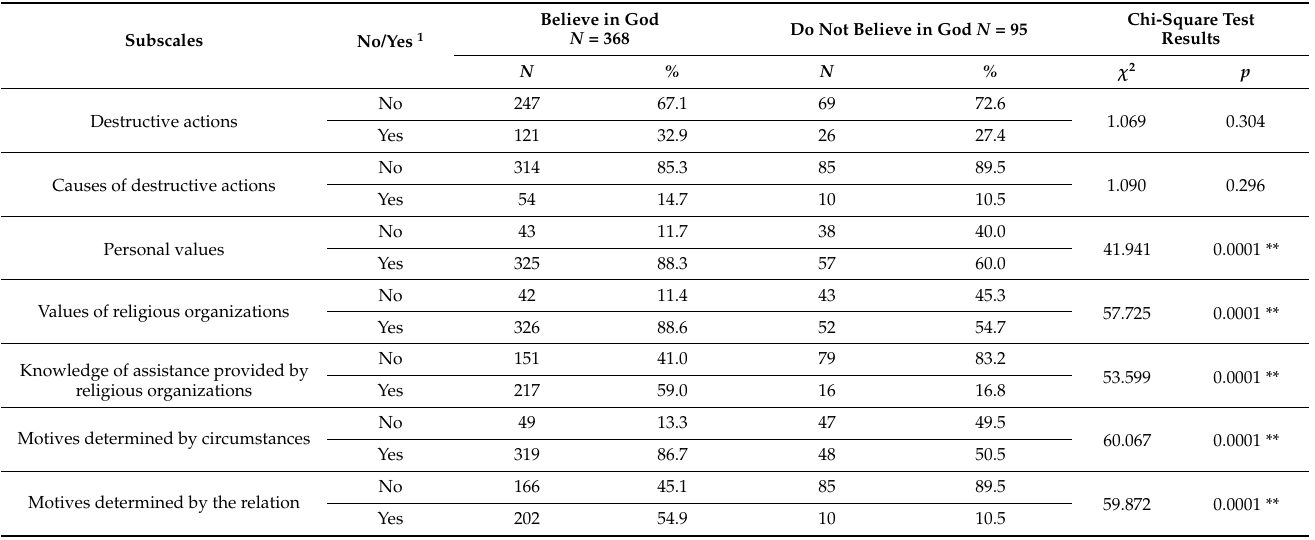
Table 6. The Chi-square test by belief in